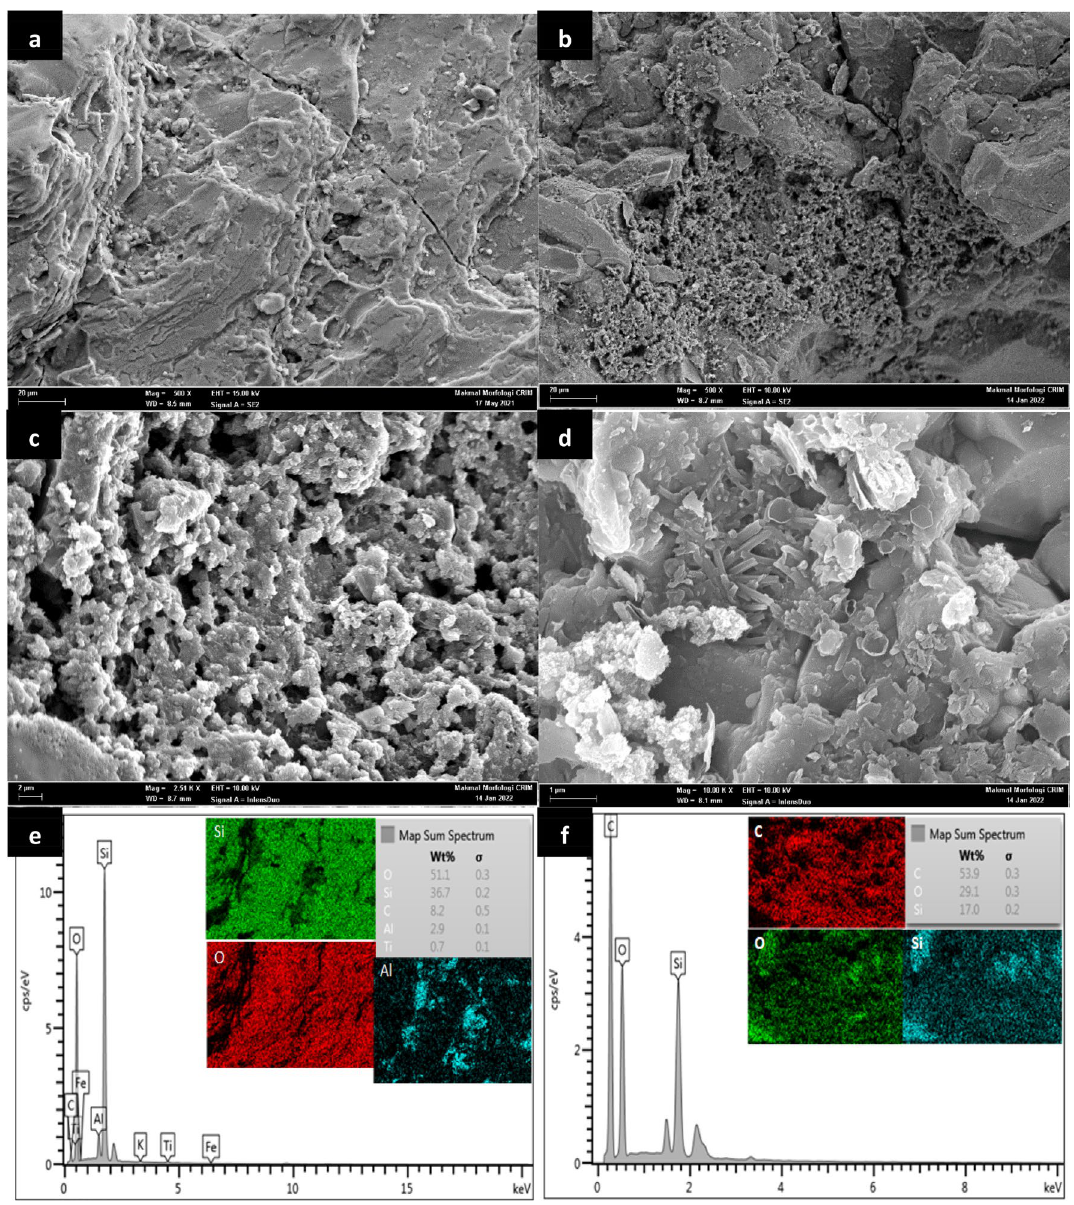
Figure 5. SEM micrograph of ( a ) sand, GSC WCO at ( b ) ×500, ( c ) ×2.5 K, ( d ) CR adsorbed GSC WCO at ×10 K magnification, and EDX/mapping of ( e ) sand, ( f ) GSC WCO